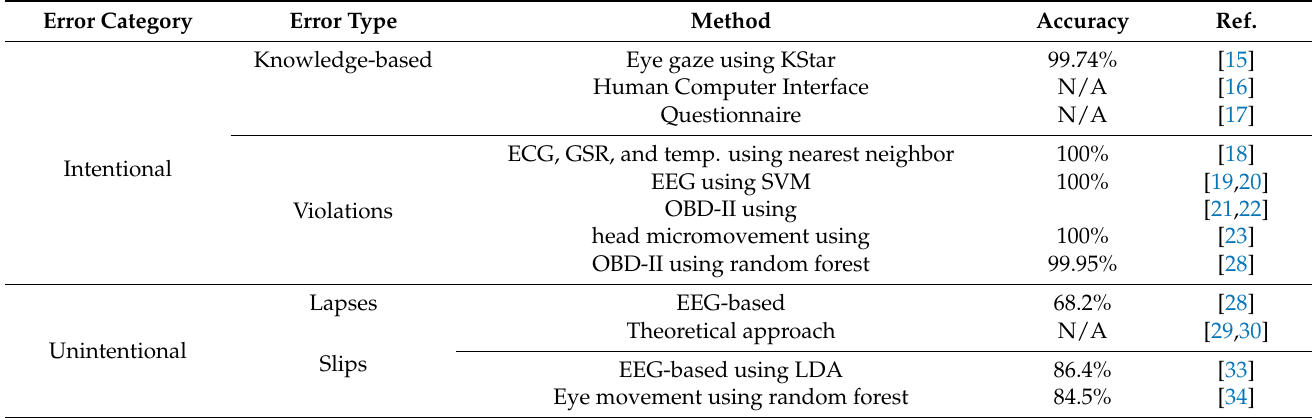
Table 1. Human error categories and detection